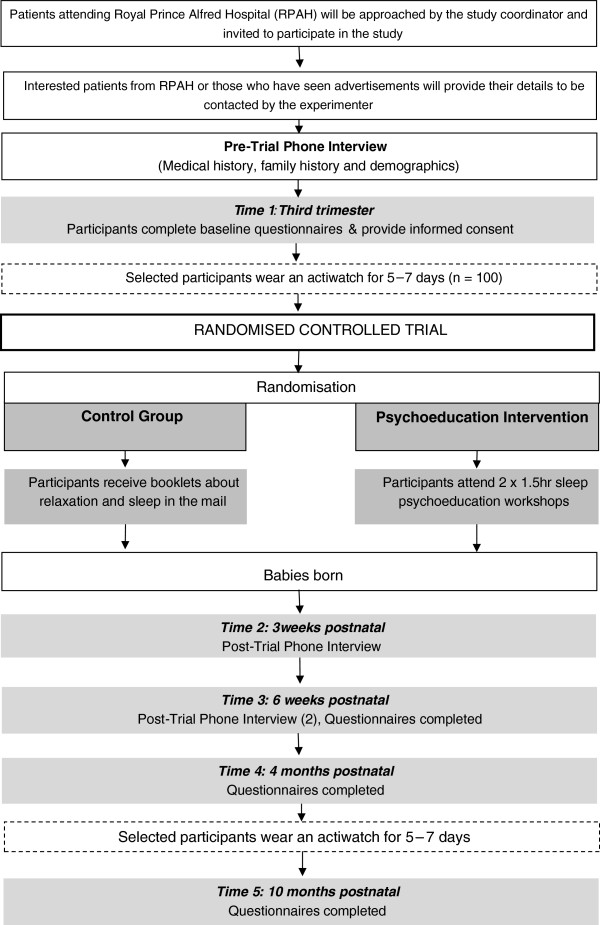
Procedure flowchart.